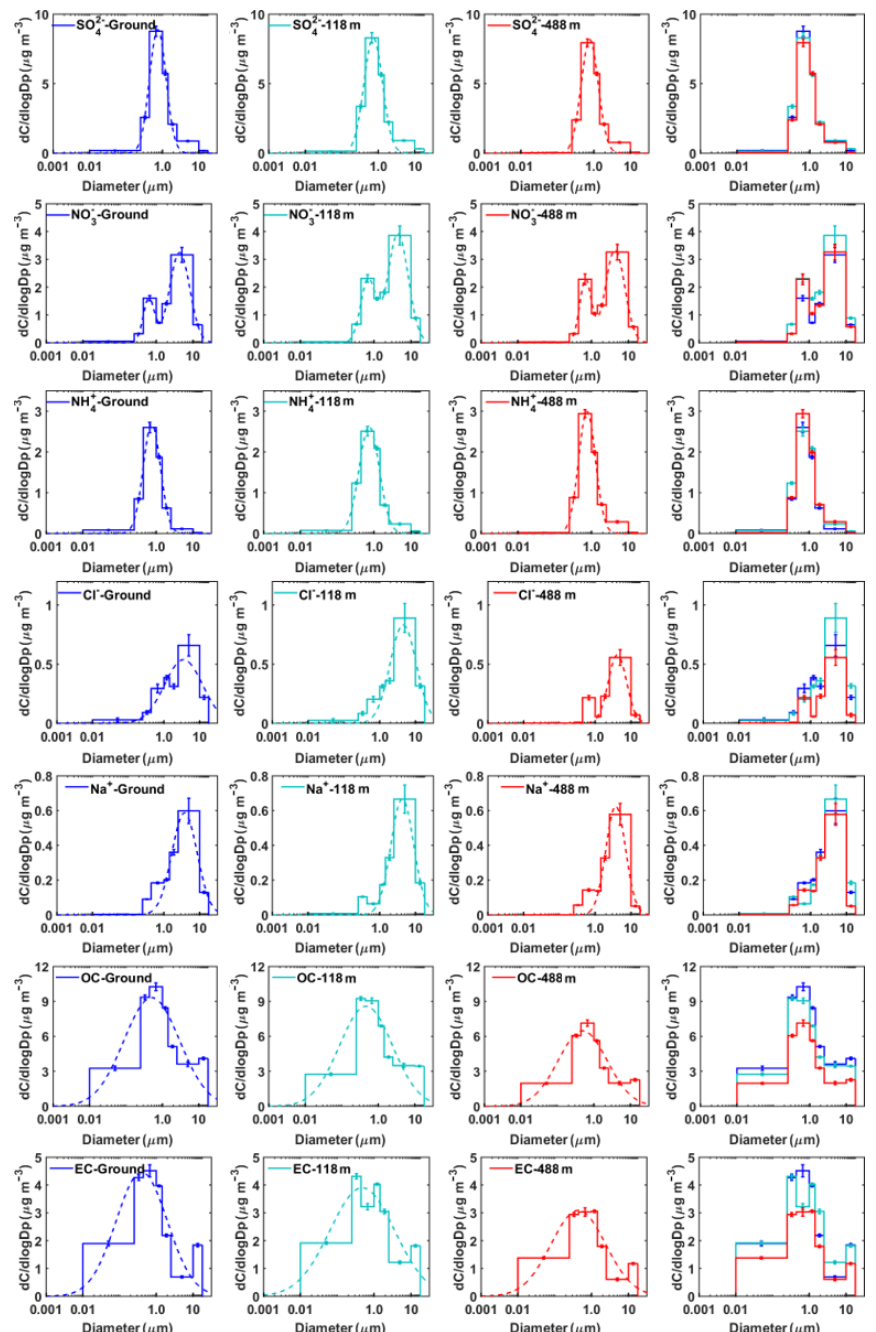
Figure 5. Mass concentration size distributions of the main chemical components measured at ground level, 118m, and 488m in autumn. The dotted lines represent the nonlinear fitting of the measured average size distribution. The error bars represent the sampling and analytical standard errors for each